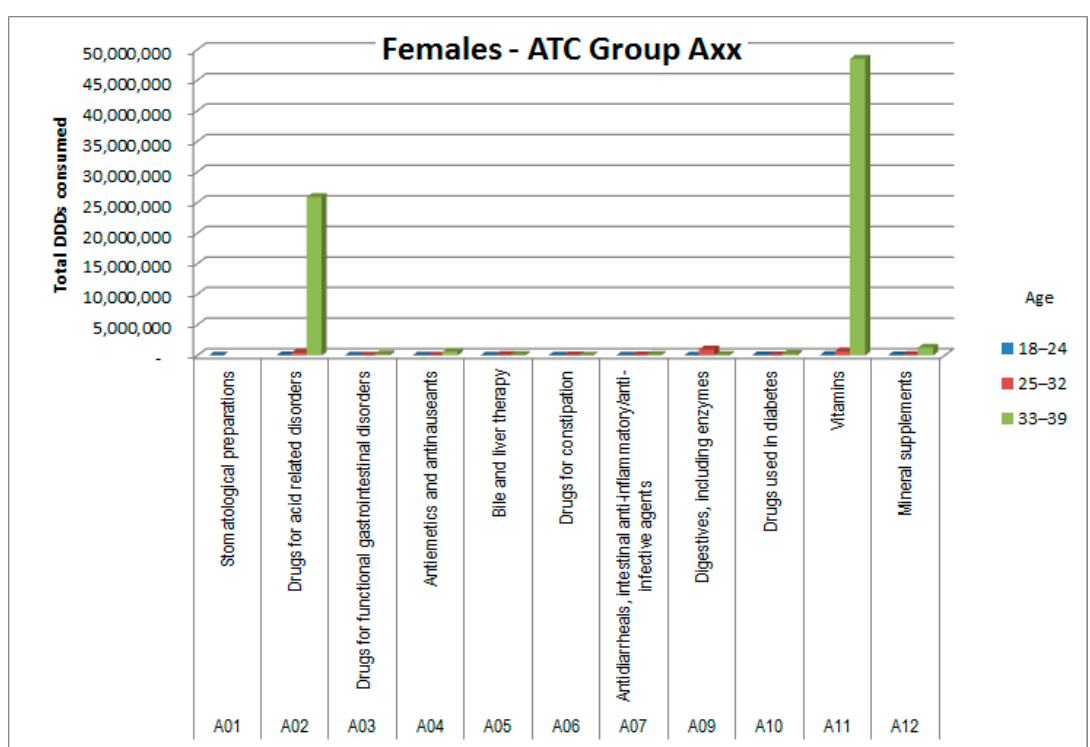
Figure 7. DDD consumption for females, ATC group Axx.